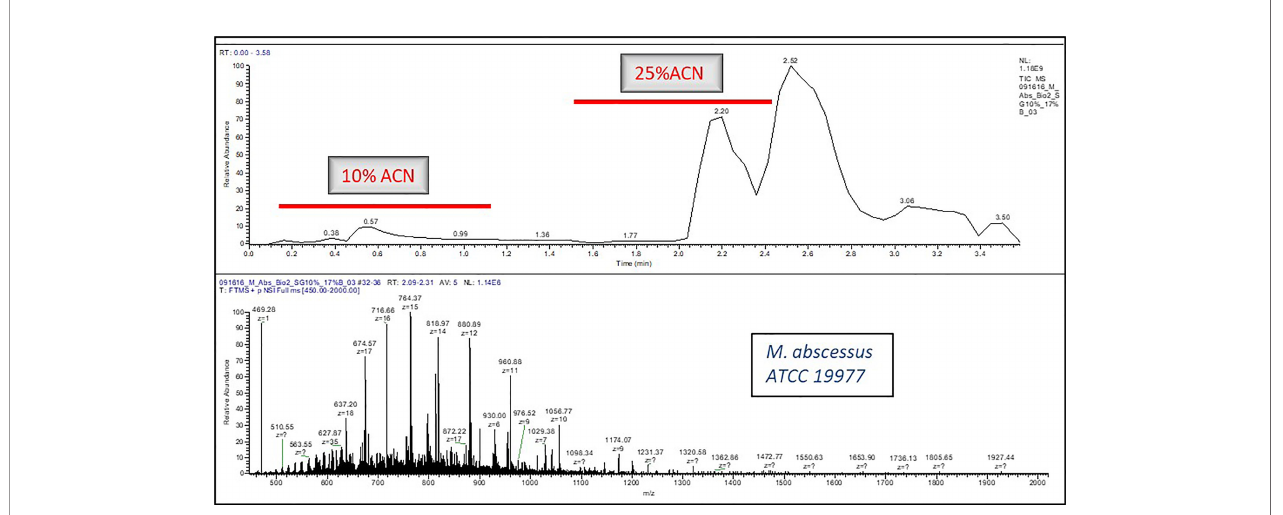
FIGURE 1 | A typical LC-MS chromatogram of Isocratic Elution for e.g., Mycobacteroides abscessus ATCC19977